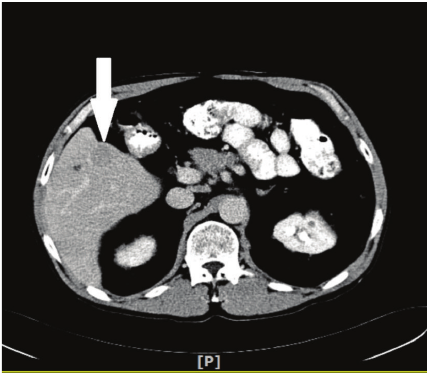
Figure 2: Hepatic lesion showing early wash out in venous